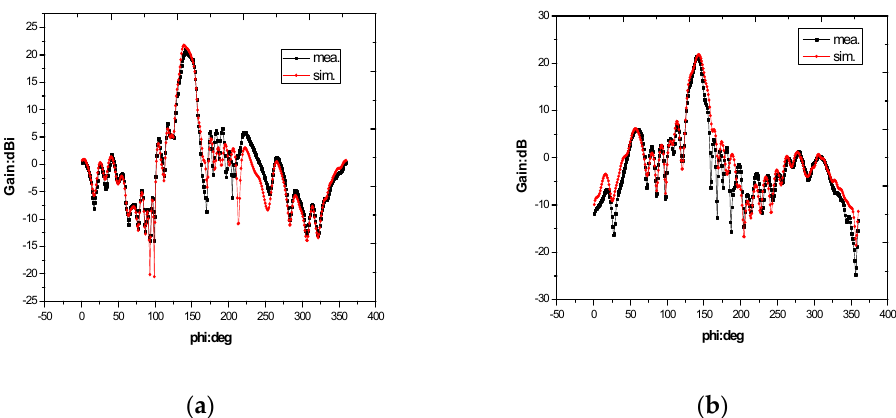
8 of 10 Figure 11. Comparison between Segment parabolic and Parabolic curved antenna. ( a ) ( b ) ( c ) Figure 12. ( a ) Three-dimensional structure of the segmented parabolic surface ( b ) Rays on segmented parabolic surface ( c ) The segmented parabolic surface in the microwave anechoic chamber. Figure 13. Segment parabolic curve antenna. 3. Simulation and Experimental Results The three-dimensional structure of the segmented parabolic surface is shown in the Figure 12 above which Figure 12c shows the antenna in the microwave anechoic chamber, and its one- dimensional graph is shown in Figure 13. In Figure 14, two curves represent the simulation result